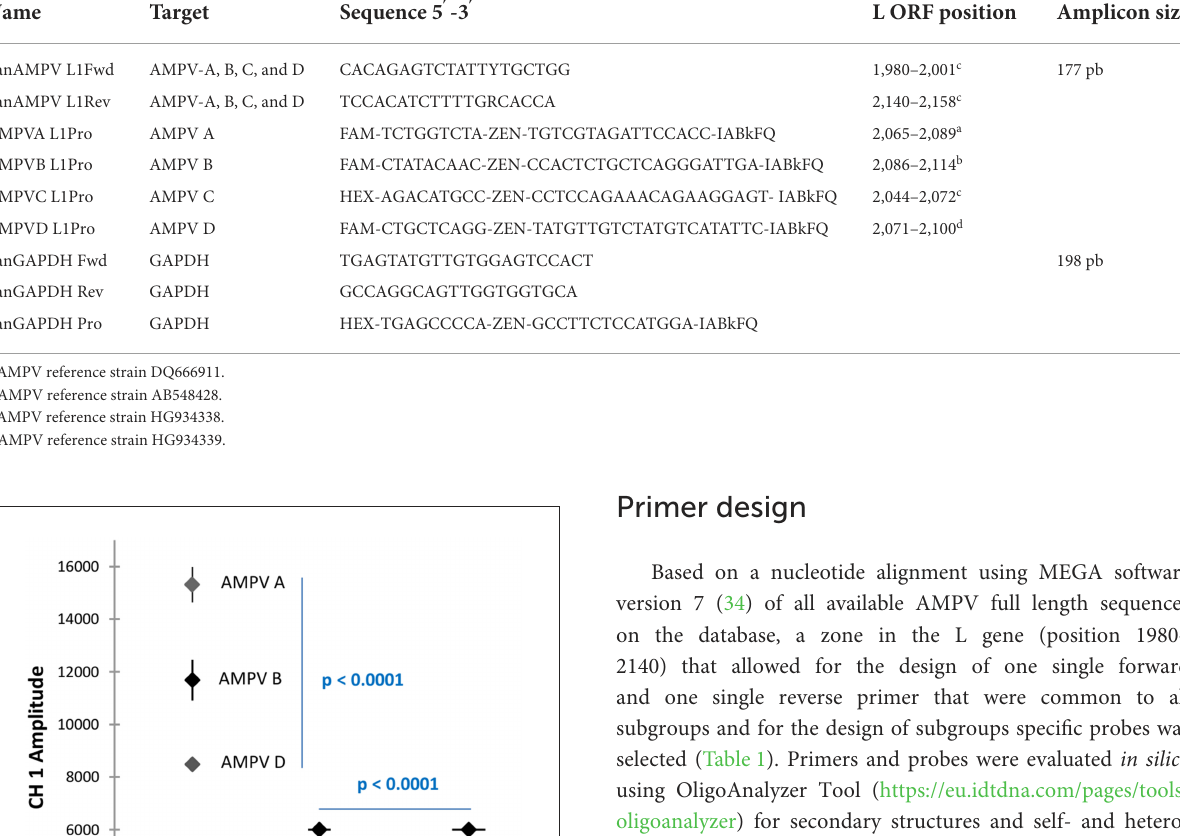
TABLE 1 Details of the five-plex RT-ddPCR AMPV primers and probes.